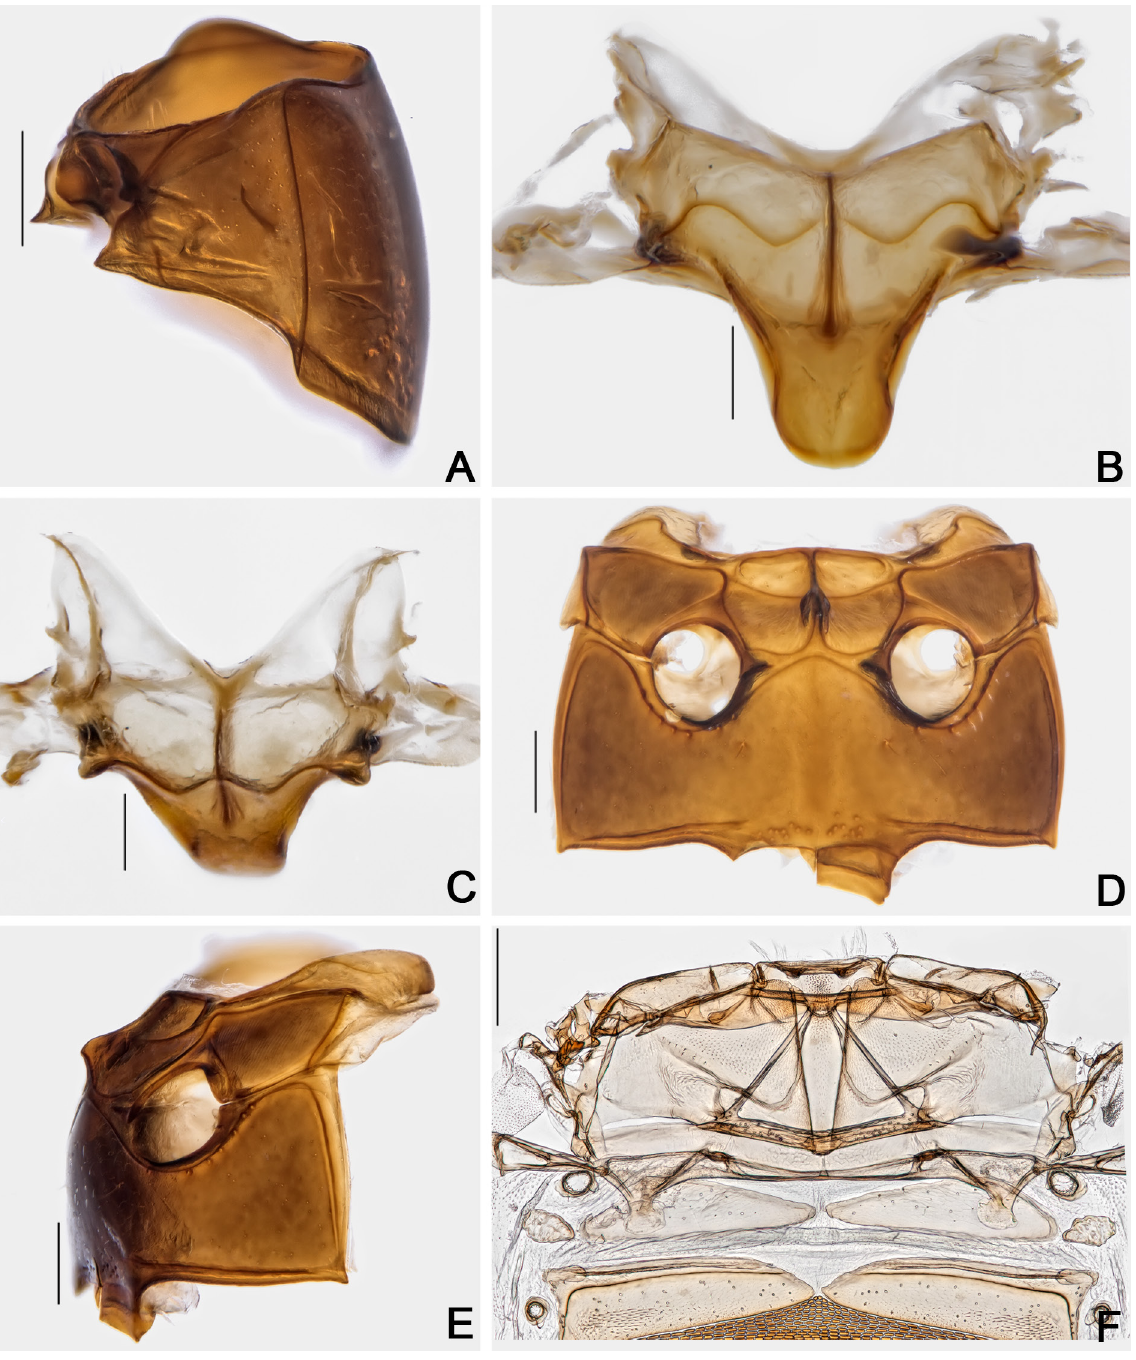
Fig. 33. Cyparium newtoni sp. nov., paratype, ♂ (CELC). A . Prothorax, lateral view. B–C . Scutellar plate. B . Dorsal view. C . Apically slanted view. D–E . Meso- and metathorax. D . Ventral view. E . Lateral view. F . Metanotum. Specimens collected at Mata do Paraíso (A. D–F) and Mata da Biologia (B–C), Viçosa (MG, Brazil). Scale bars: A, D–F = 0.2 mm; B–C = 0.1